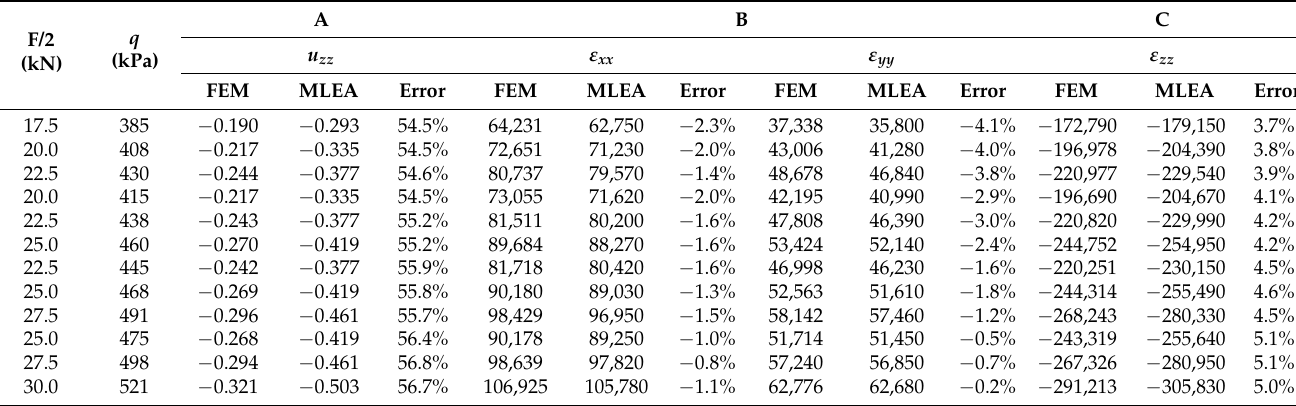
Table 11. Critical stresses and strains between two tyres based on the twin tyre finite element simulation (FEM) and the substituting circular plate model (MLEA).